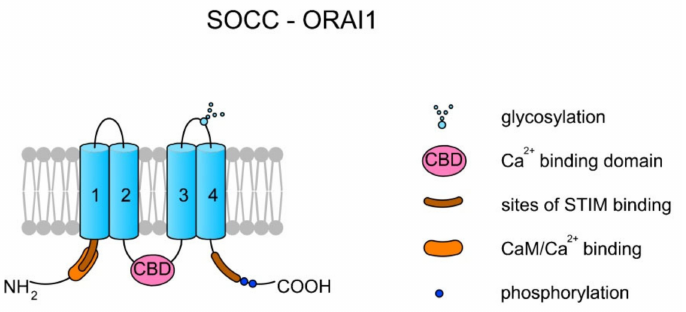
Figure 2. Topology of a store-operated Ca 2+ channel (SOCC) created by ORAI1. Each ORAI protein has four TMs. TM2 and TM3 create a pore. There are two sites for STIM1 binding at the N- and C-termini. The interaction between STIM1 and ORAI activates the channel and the release of Ca 2+ from the endoplasmic reticulum (ER). The binding of Ca 2+ by the Ca 2+ binding domain (CBD) localized on the central loop inactivates the channel [51]. Additionally, it can also be inactivated upon CaM binding